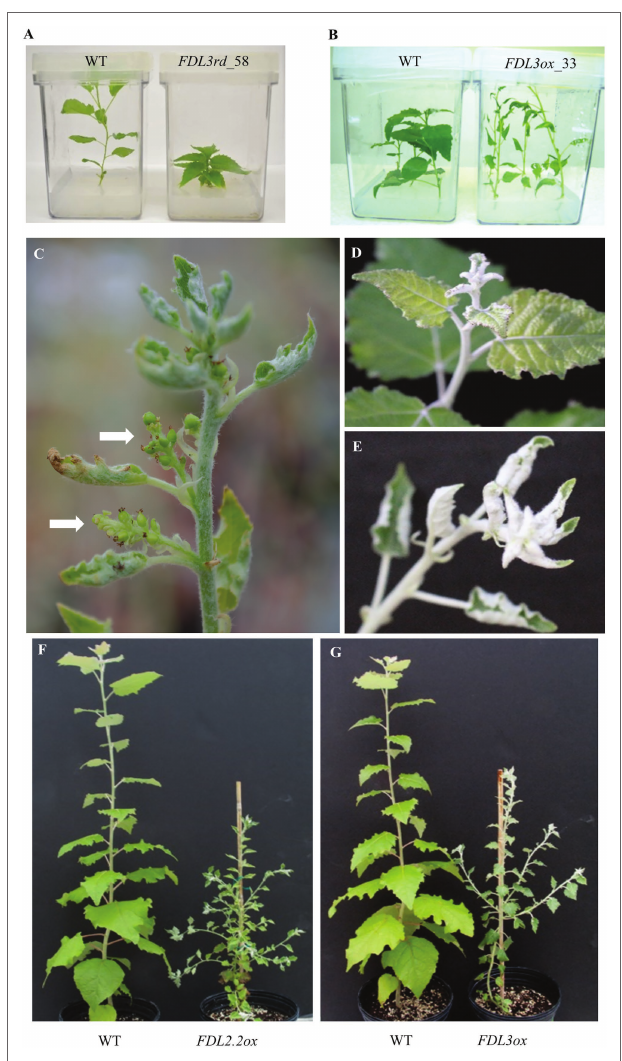
FIGURE 3 | Overexpression of FDL3 affects leaf size and shoot elongation but does not promote flowering. Representative plants showing opposite effects on shoot elongation in vitro of (A) FDL3 dominant repression ( FDL3rd ) vs. (B) overexpression ( FDL3ox ). In (A) WT plant is 6-week-old, whereas FDL3rd plant is 10-week-old and in (B) , WT and FDL3ox were propagated at the same time and are 4-week-old in the photo. Shoot apices of (C) FDL2.2ox with consecutive axillary inflorescences, (D) WT, and (E) FDL3ox . White arrows in (C) point to axillary inflorescences with multiple female flowers. (F) A premature flowering FDL2.2ox plant with many inflorescences as shown in (C) on both the main shoot and branches. (G) A FDL3ox plant with a few branches, but no flowers. (C–G) All photos are of 6-month-old plants grown at the same time in a greenhouse under a 16-h